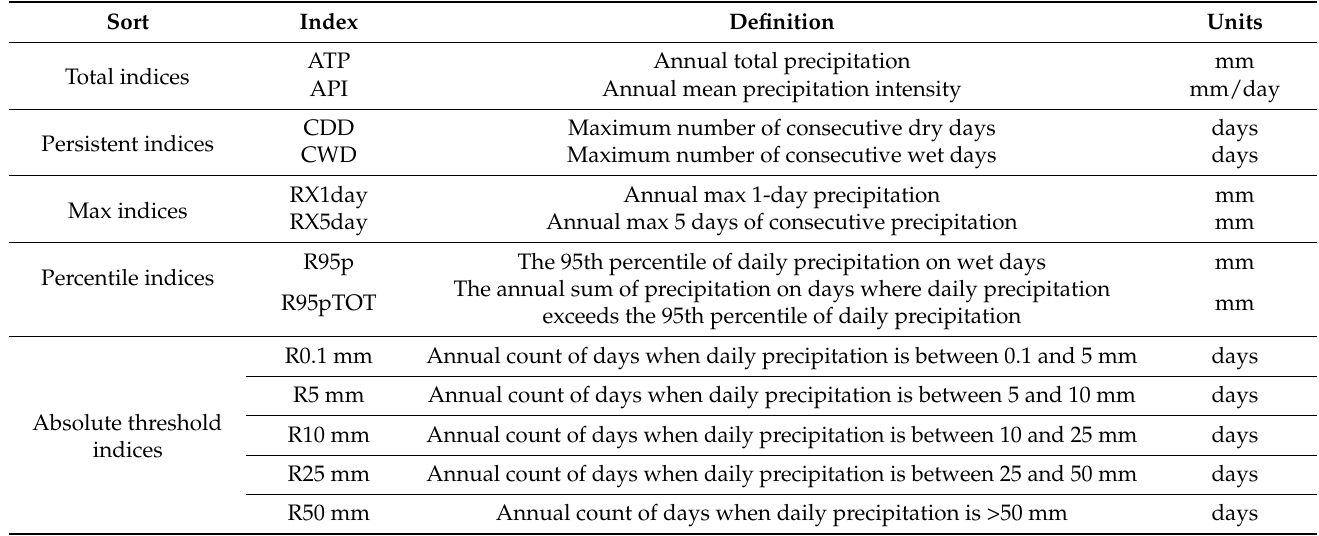
Table 4. Detailed information regarding extreme precipitation